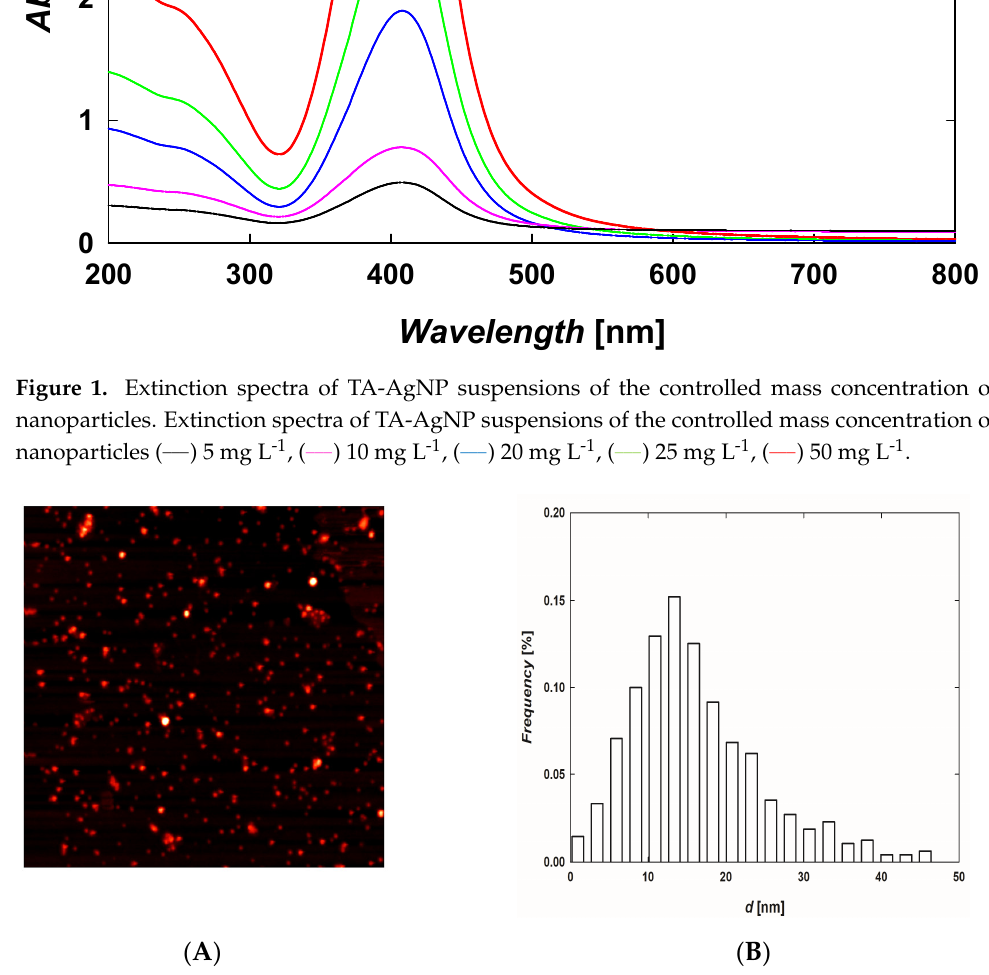
Figure 2. ( A ) Typical AFM image (2 μm × 2 μm) presenting TA-AgNPs deposited on PAH-modified mica and ( B ) size distribution of nanoparticles.